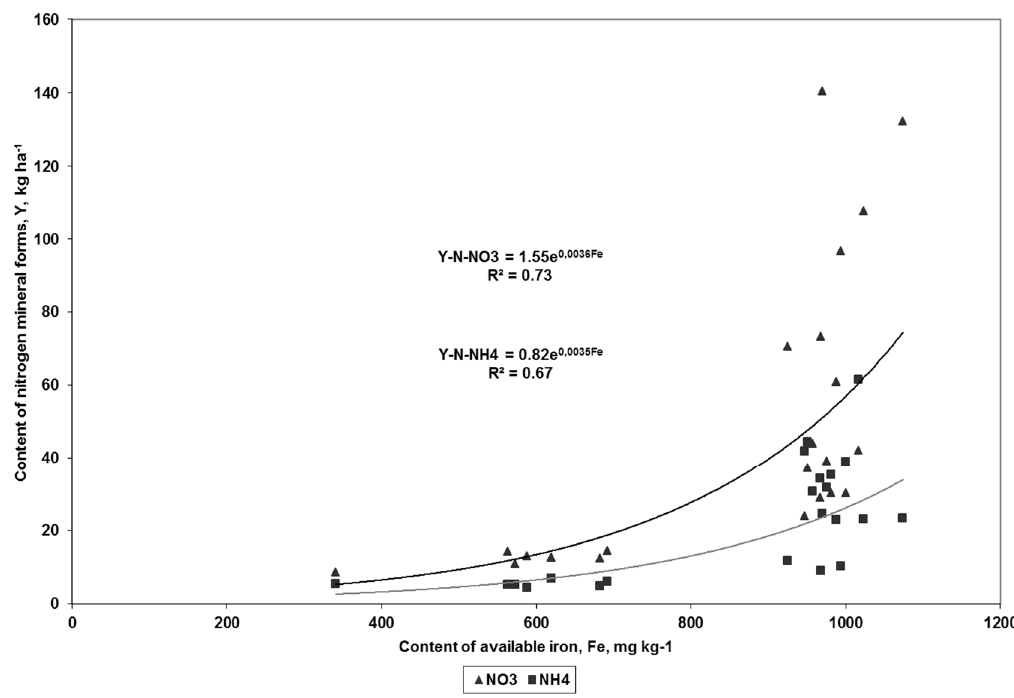
Figure 4. The content of mineral nitrogen forms as a function of the content of available iron.